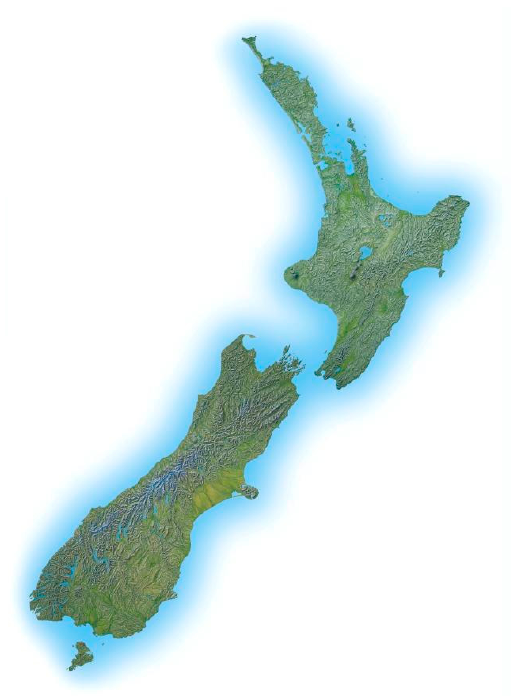
Figure 1. Reference [8] New Zealand—an island nation with a national property rights system.